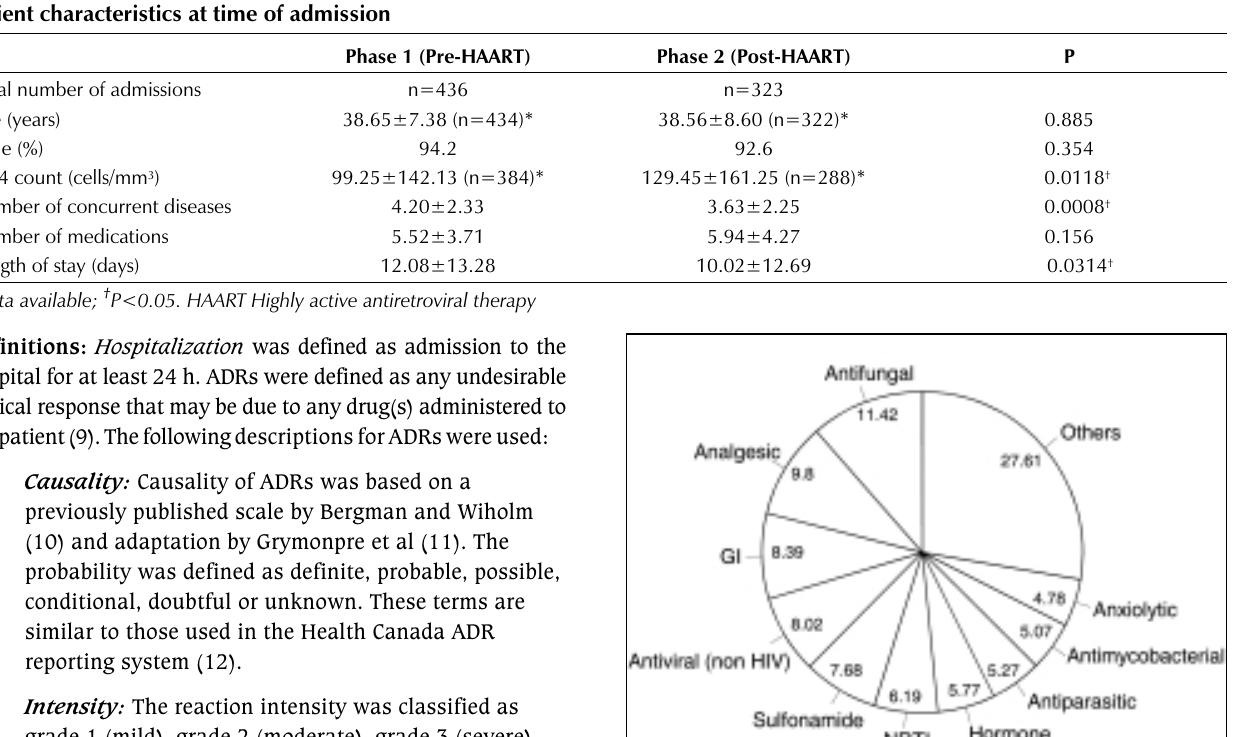
TABLE 1 Patient characteristics at time of admission